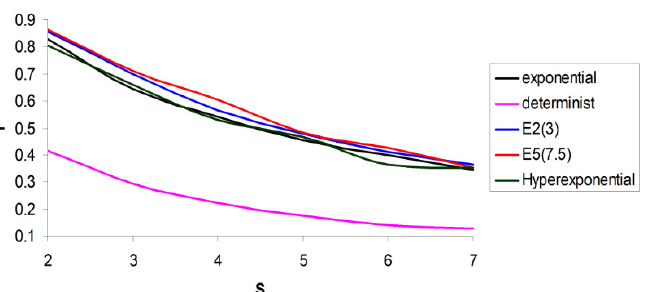
Figure 14. Comparative graphics of r for some distributions of inter-arrival times with a = 1.5; u =